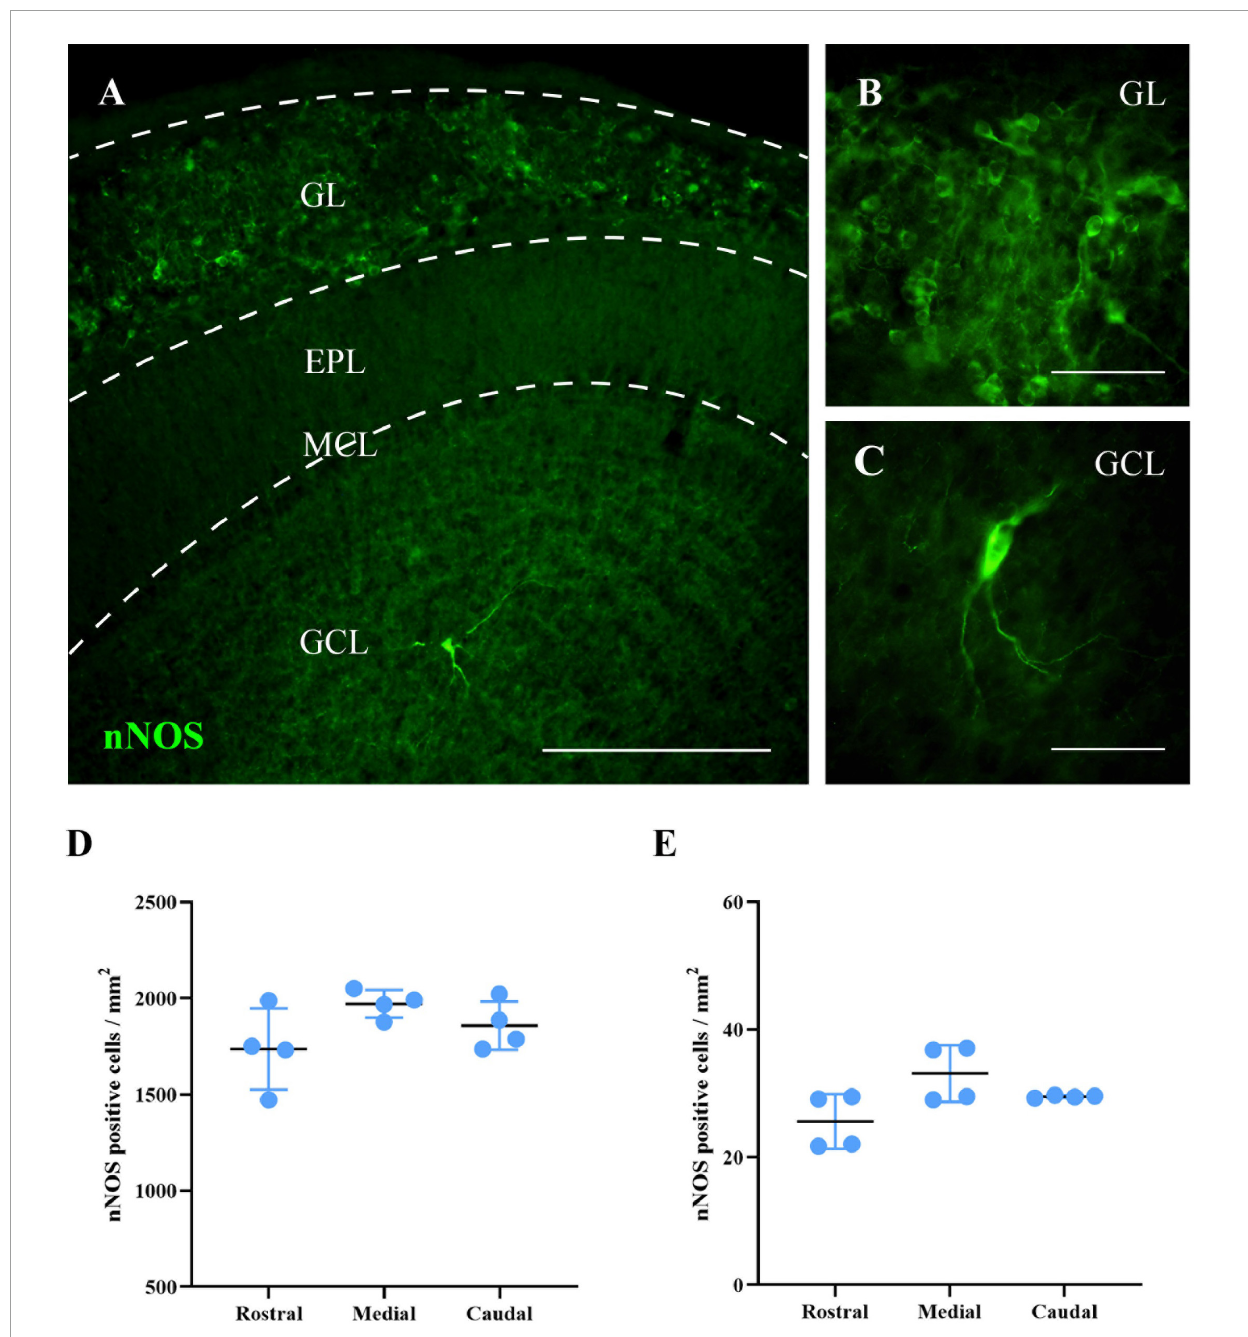
FIGURE2 Labeling of nNOS in the MOB of wild-type mice. (A) Image showing a panoramic view of the nNOS labeling (green). (B,C) Magnifications of neurons labeled for nNOS in GL (B) and GCL (C) . (D,E) Charts summarizing the analyses of the density of cells positive for nNOS in the GL (D) and GCL (E) , in different levels of the MOB (rostral, medial, and caudal). The same density of nNOS positive cells per mm 2 was observed throughout the entire area of the GL, with no significant differences among the levels analyzed (rostral 1,736 ± 211 cells/mm 2 , medial 1,971 ± 72 cells/mm 2 , caudal 1,858 ± 126 cells/mm 2 ; p = 0.146) or the GCL (rostral 25 ± 4 cells/mm 2 , medial 33 ± 4 cells/mm 2 , caudal 29 ± 1 cells/mm 2 ; p = 0.116). Scale bars 200 µ m (A) and 100 µ m (B,C) .